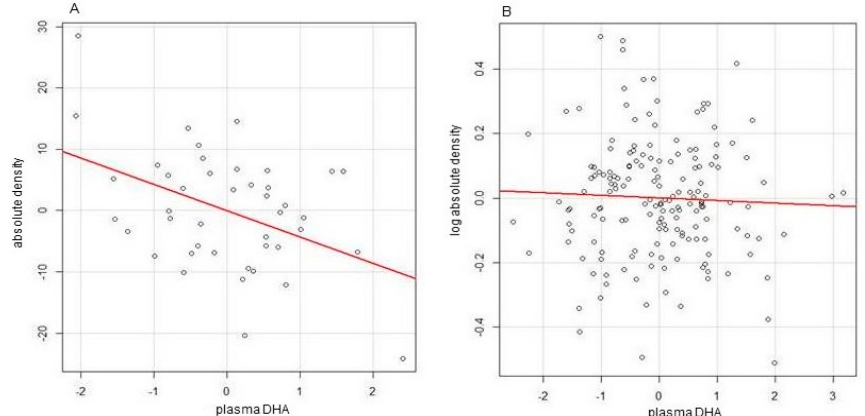
Figure 1. Partial regression plot of the dependence of absolute breast density on docosahexaenoic acid (DHA) after adjusting for other predictors for body mass index (BMI) > 29 ( A ) and ≤ 29 ( B ) Reproduced with permission from [54].